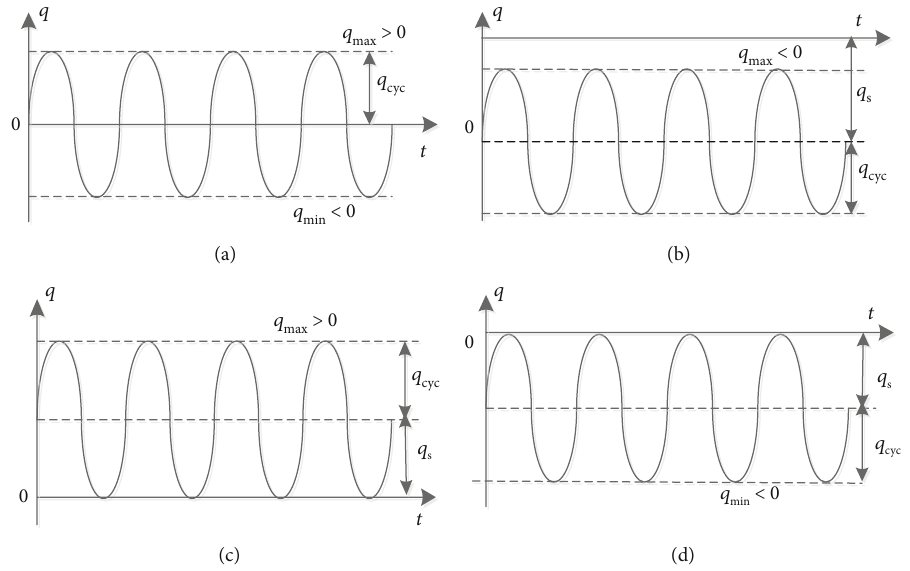
Figure 3: Categories of stress conditions considered in this study: (a) stress reversal; (b) no stress reversal; (c, d)